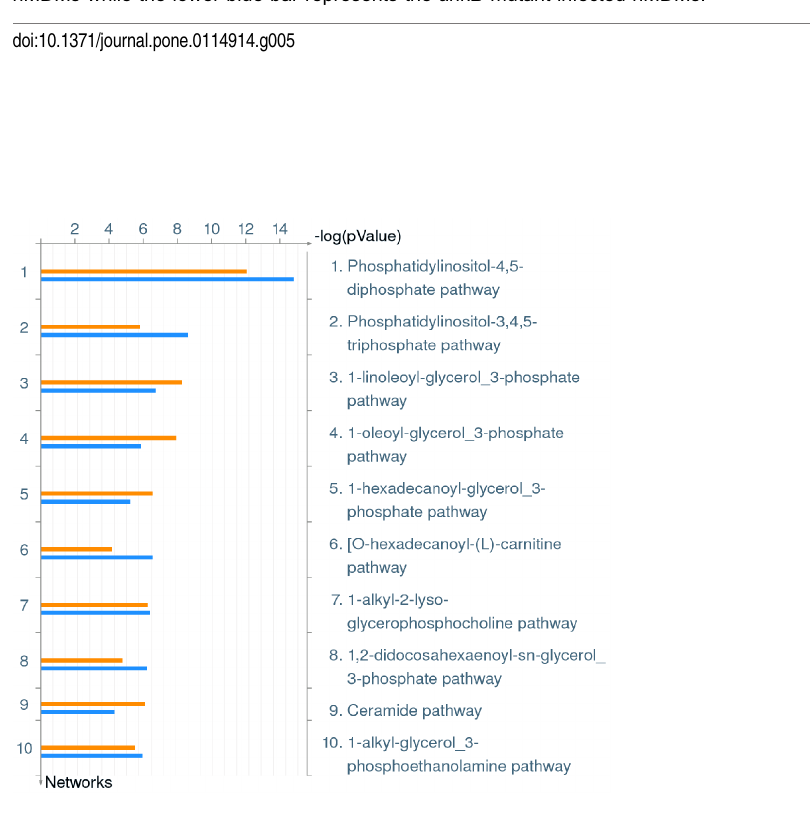
Figure 6. Top 10 Metabolic Pathways down-regulated in hMDMs upon infection by L. pneumophila . Metacore analysis of triplicate microarrays of wild type strain and ankB mutant-infected hMDMs 8 h post- infection showing the top 10 Metabolic Pathways. The upper orange bar of each column represents wild type- infected hMDMs while the lower blue bar represents the ankB mutant-infected